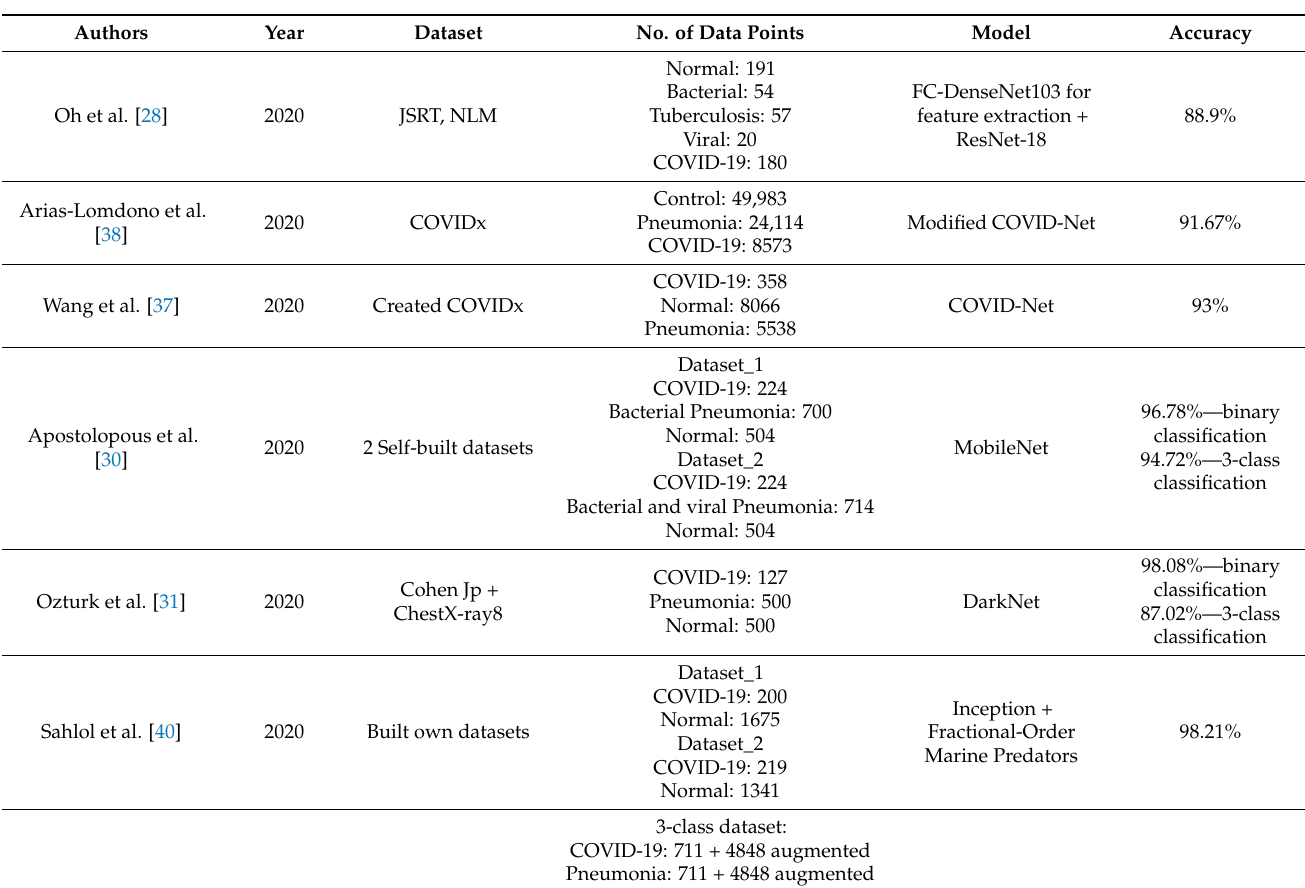
Table 3. Summary of work using deep learning for COVID-19 classification through